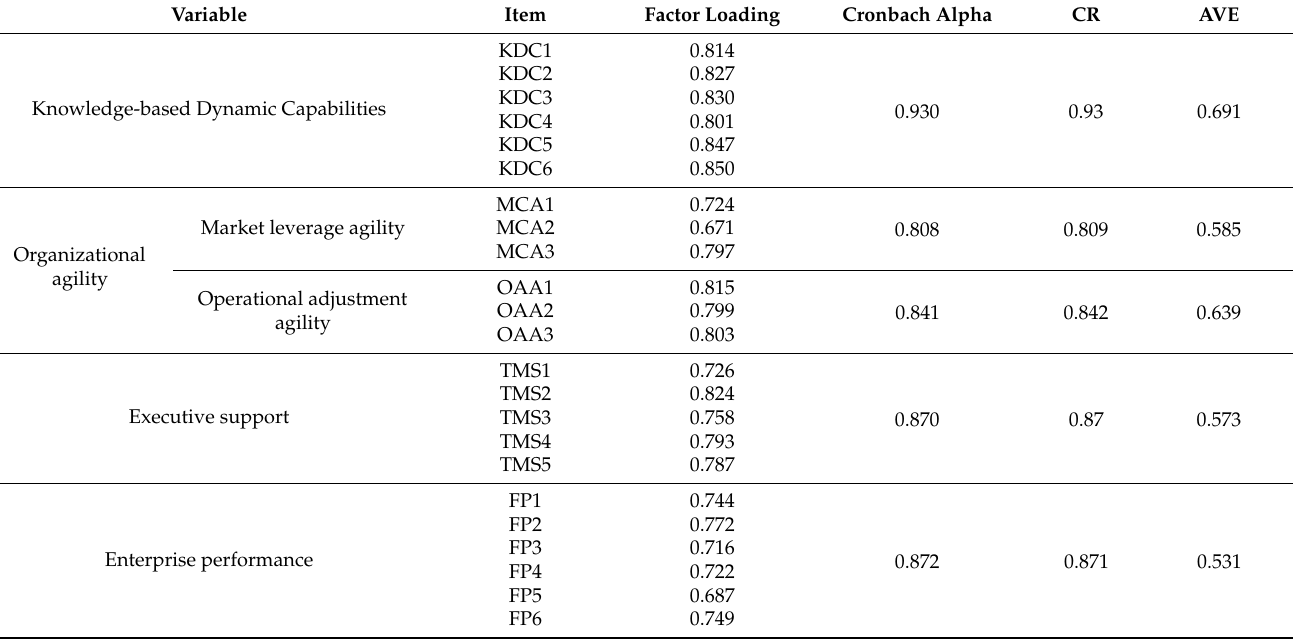
Table 2. Reliability and validity test of